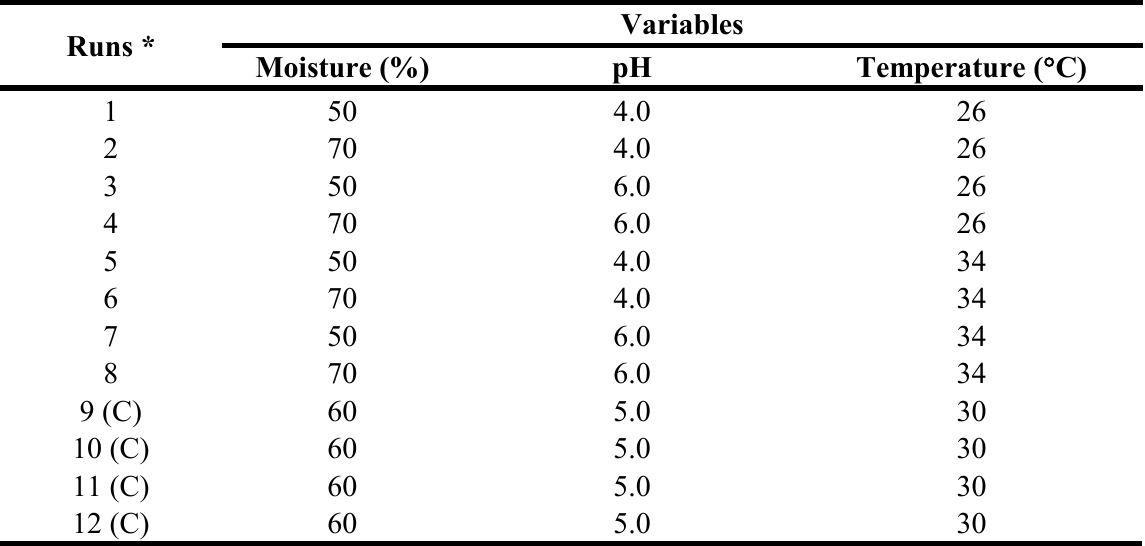
Table 3. Full factorial design (2 3 ) for the production of phytase and xylanase by solid state fermentation using citrus pulp as